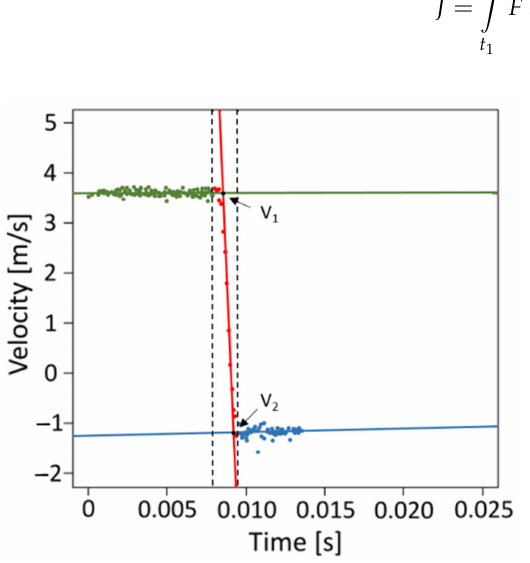
Figure 10. Average velocity of an impactor with mass = 0.061 kg dropped from a height of 0.81 m onto a fresh lemon sample. The impactor’s position is calculated for each point in time by averaging five tracking points on the impactor. The intersections of the regression lines show the velocities immediately before (v 1 ) (intersection of the green and red regression lines) and after (v 2 ) the impact (red and blue regression